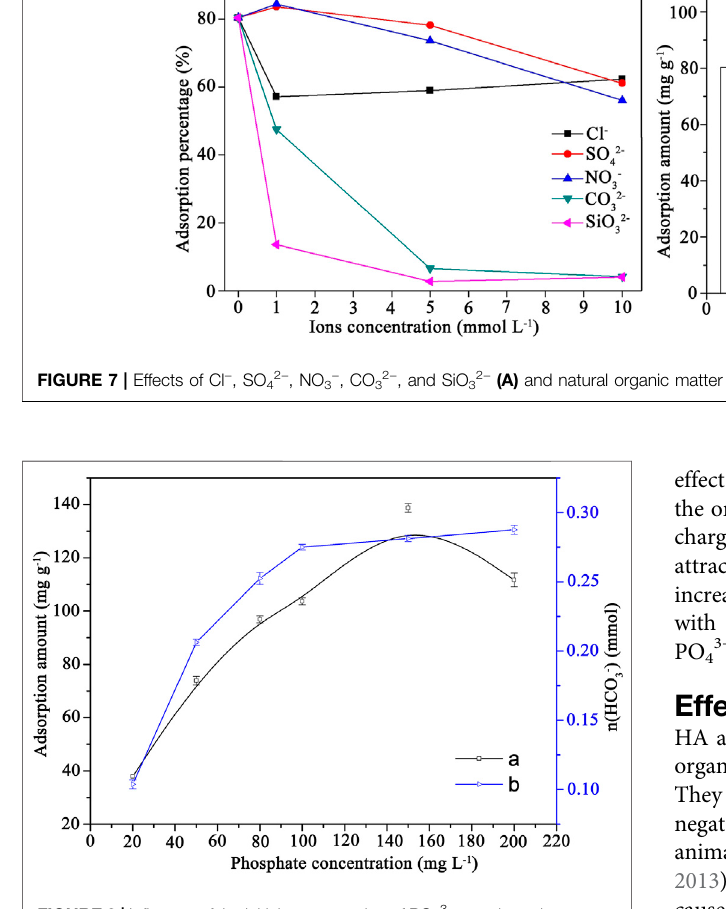
FIGURE 8 | In fl uence of the initial concentration of PO 43 − on adsorption amount of PO 43 − (A) . Total molar volume of bicarbonate in the solution after adsorption (B)